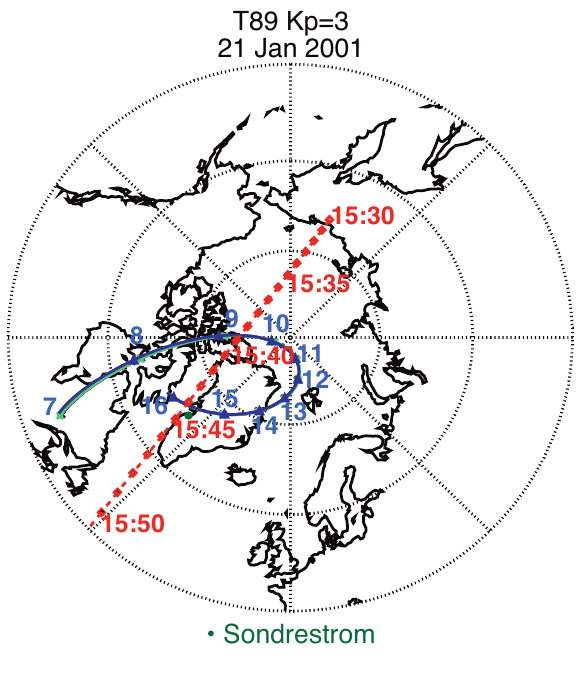
Fig. 6. Solar wind from SOHO/CELIAS and IMF from ACE on 21 January 2001. The time refers to the ACE spacecraft and does not include a delay of 75min (confirmed by observations as discussed in the text). Top to bottom: Solar wind density, velocity, temperature, and dynamic pressure; total magnetic field, its GSM components, and clock angle.